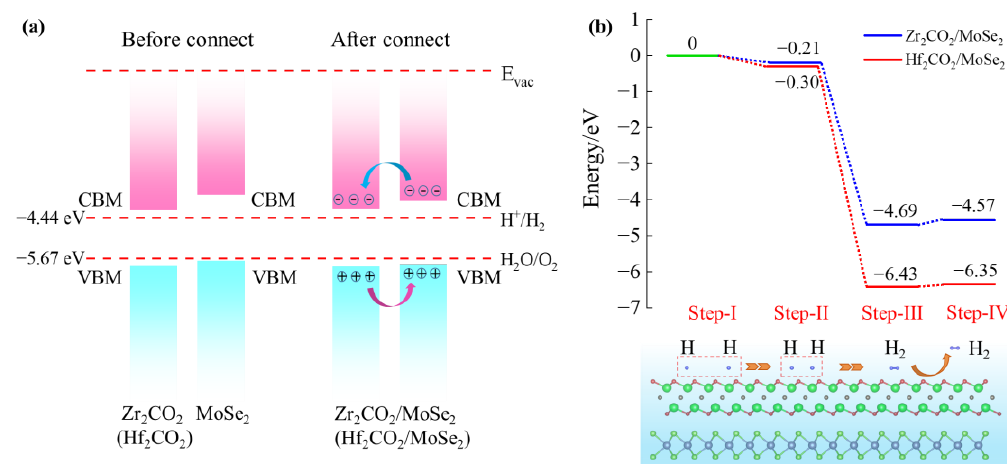
Figure 9. ( a ) The schematic illustrations of the charge transfer paths and overall water splitting of Zr 2 CO 2 /MoSe 2 (Hf 2 CO 2 /MoSe 2 ) heterostructure. ( b ) The generation processes of hydrogen on the Zr 2 CO 2 (Hf 2 CO 2 ) surface of Zr 2 CO 2 /MoSe 2 (Hf 2 CO 2 /MoSe 2 ) heterostructure.